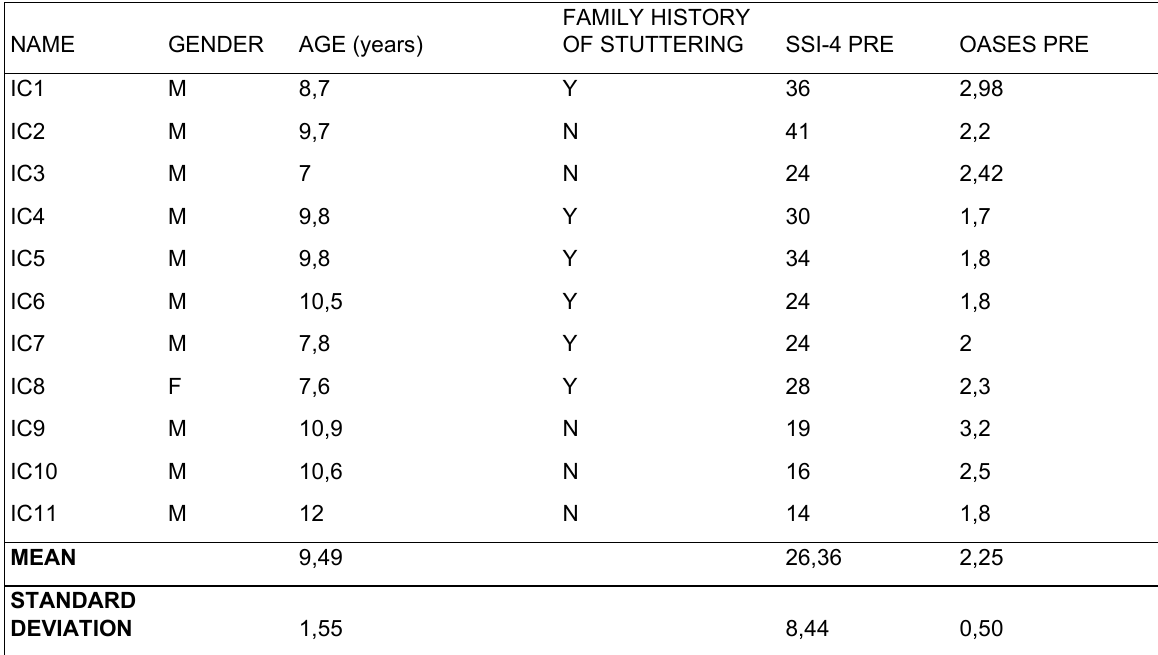
Baseline Characteristics of Patients in Clinic